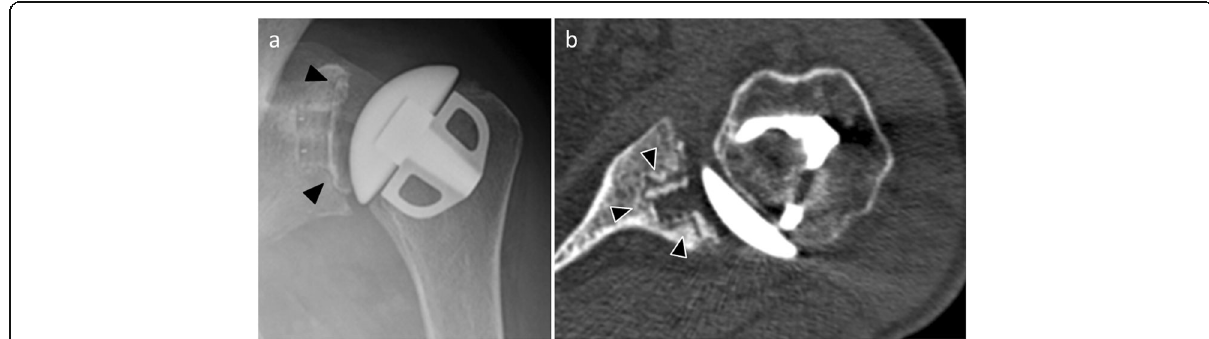
Fig. 17 a Anteroposterior shoulder radiograph of a 61-year-old man with total shoulder arthroplasty shows a radiolucent line around the glenoid